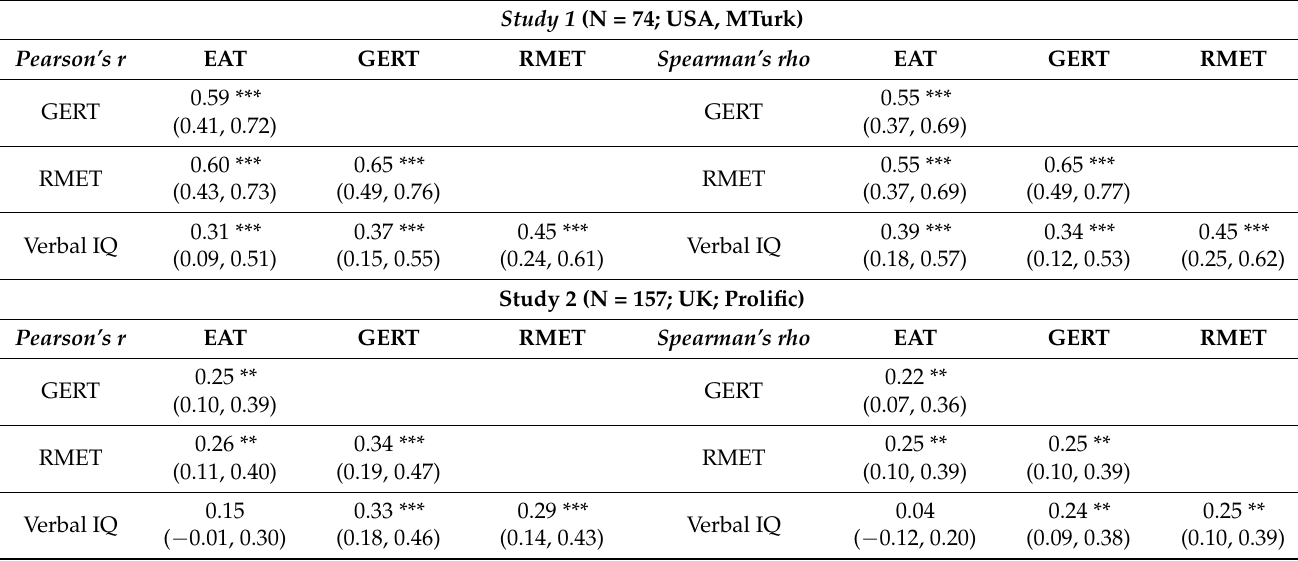
Table 2. Pearson and Spearman rho correlation coefficients for the associations of performance as measured across pairs of tasks, in Study 1 and